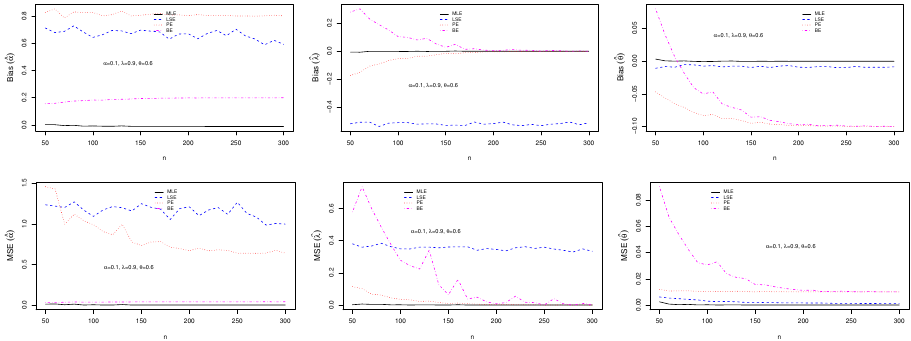
Figure 6. Plots of the bias and MSE for the different estimates of α = 0.1, λ = 0.9 and θ = 0.6.